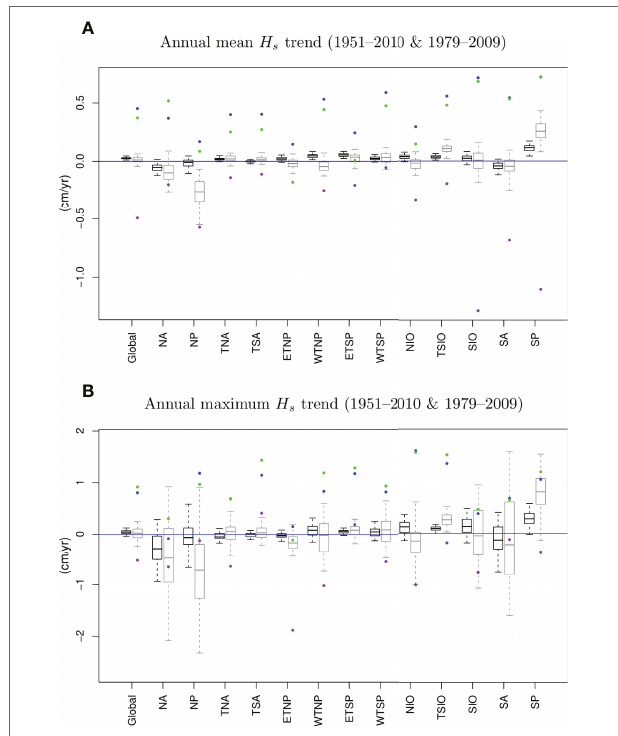
FIGURE 3 | Ensemble average of the regional trend (cm/yr) of the annual mean (A) and maximum (B) H s averaged over the indicated area (see Figure1 ), corresponding to the 1951–2010 (black) and 1979–2010 (gray) periods. Dots indicate: ERA5 (blue), ERAint (green) and CFSR (purple) corresponding values for 1979–2010. Box plot illustrates the 2.5%, 25%, 50%, 75% and 97.5%